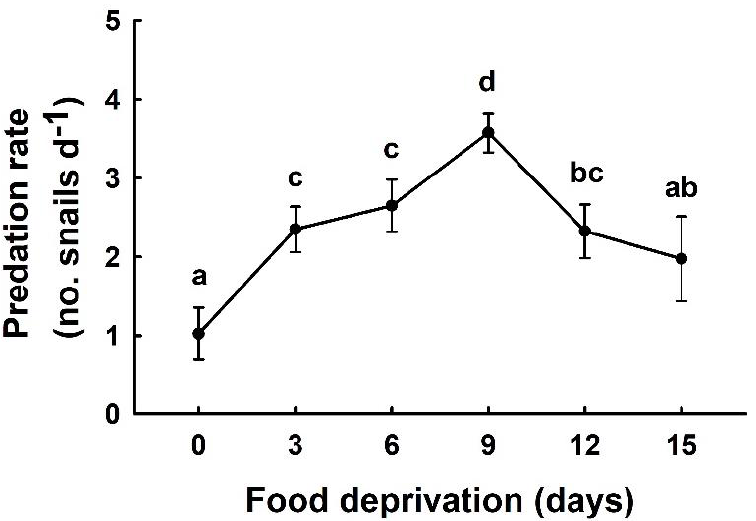
Figure 2. Predation rate of Eriocheir sinensis under different degrees of food deprivation. Different lowercase letters denote significant differences from Duncan’s post hoc test.